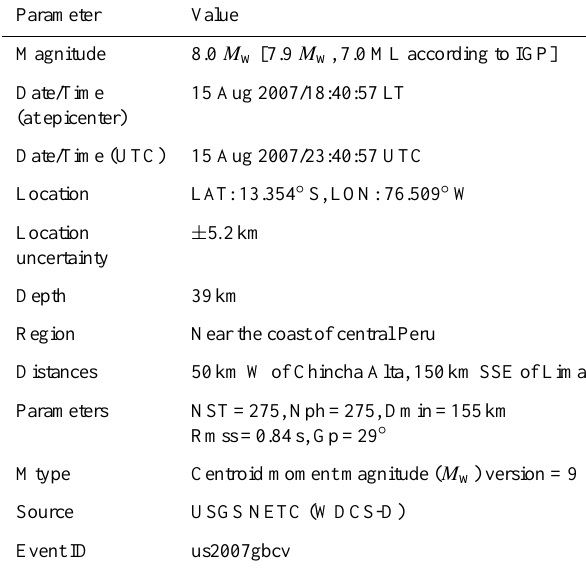
Table 1. Pisco, Peru 15 August 2007 earthquake parameters.